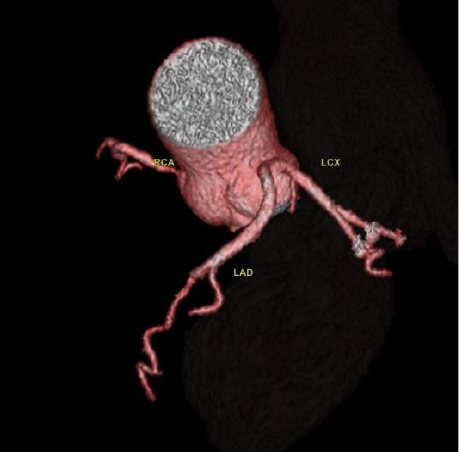
Figure 3. Separate origins of the left anterior descending artery and circumflex artery from the left anterior coronary sinus. CCTA Volume rendered 3D images of the vascular tree anatomy, showing the LAD and LCX arise directly from the left coronary sinus. RCA with normal origin from the right coronary sinus and normal course.